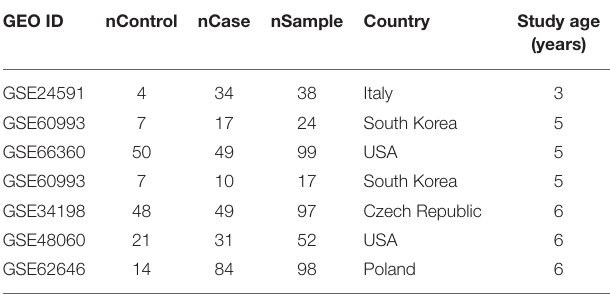
TABLE 1 | The seven MI expression datasets selected for